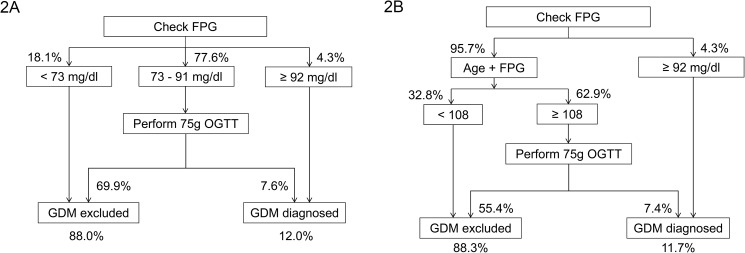
Algorithm (A) A and (B) B to screen gestational diabetes mellitus. The percentages of pregnant women in the training cohort are shown. Age + FPG, age in years plus fasting plasma glucose in mg/dL (plasma glucose in mg/dL = plasma glucose in mmol/L * 18). FPG, fasting plasma glucose; GDM, gestational diabetes mellitus; OGTT, oral glucose tolerance tests; GDM excluded, pregnant women who were diagnosed as not having GDM; GDM diagnosed, pregnant women who were diagnosed as GDM.